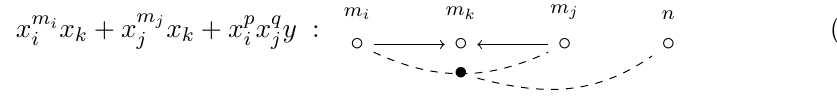
, we must have p 1 − q k j